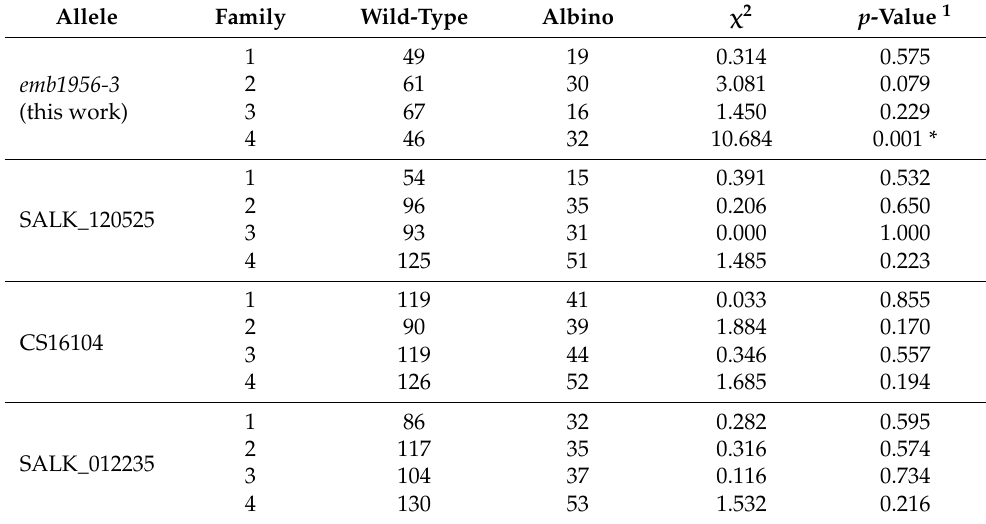
Table 1. Segregation of albino embryos in F 2 families segregating mutant alleles of the At2g04030